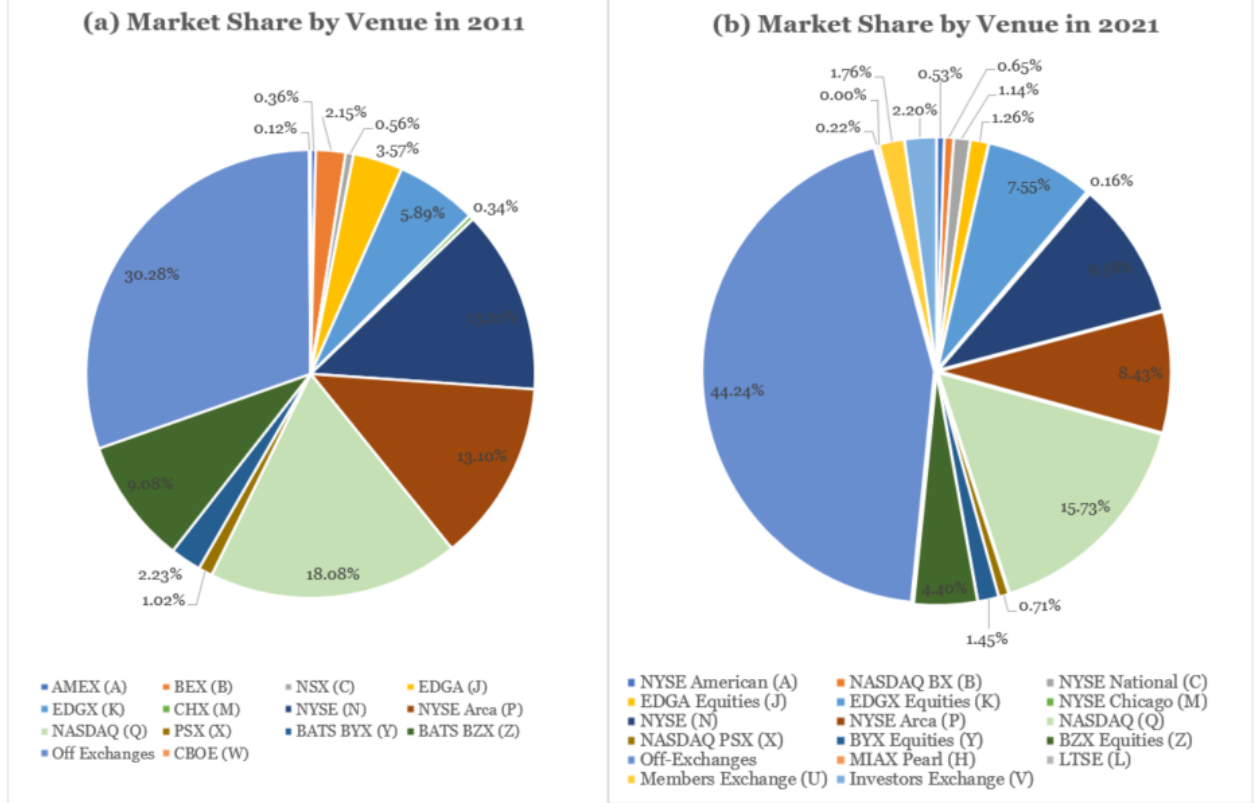
Figure 2. The average market share by venue in 2011 vs. 2021. This figure presents the changes in the market share by venue in 2011 (panel a ) vs. 2021 (panel b ). The market share is calculated as the volume executed on a particular market venue divided by the total volume on all venues. The volume data by the exchange is obtained from the CBOE’s U.S. Equities Market Volume Summary (https://www.cboe.com/us/equities/market_share, accessed date: 20 August 2021).